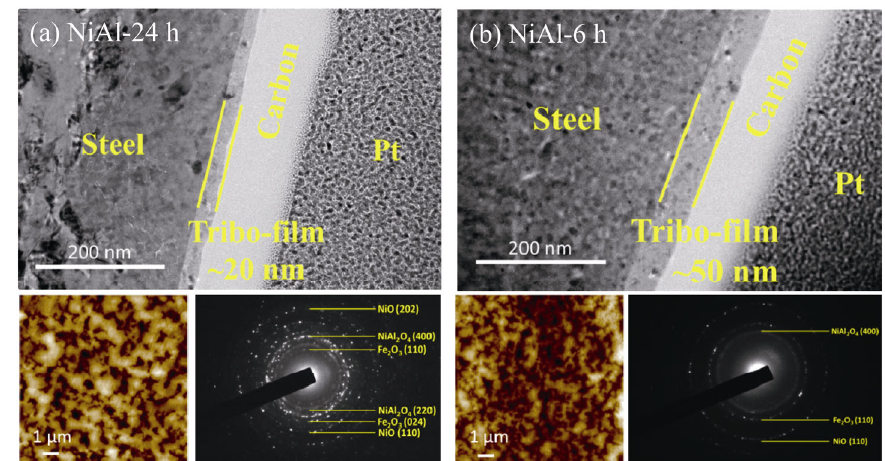
Fig. 8 Analysis of tribofilm formed on the wear track lubricated by (a) 1 wt% NiAl-24 h and (b) 1 wt% NiAl-6 h at 100 N. Cross-sectional TEM image, surface topography by AFM, and diffraction pattern of tribofilm. Reproduced with permission from Ref. [71], © American Chemical Society